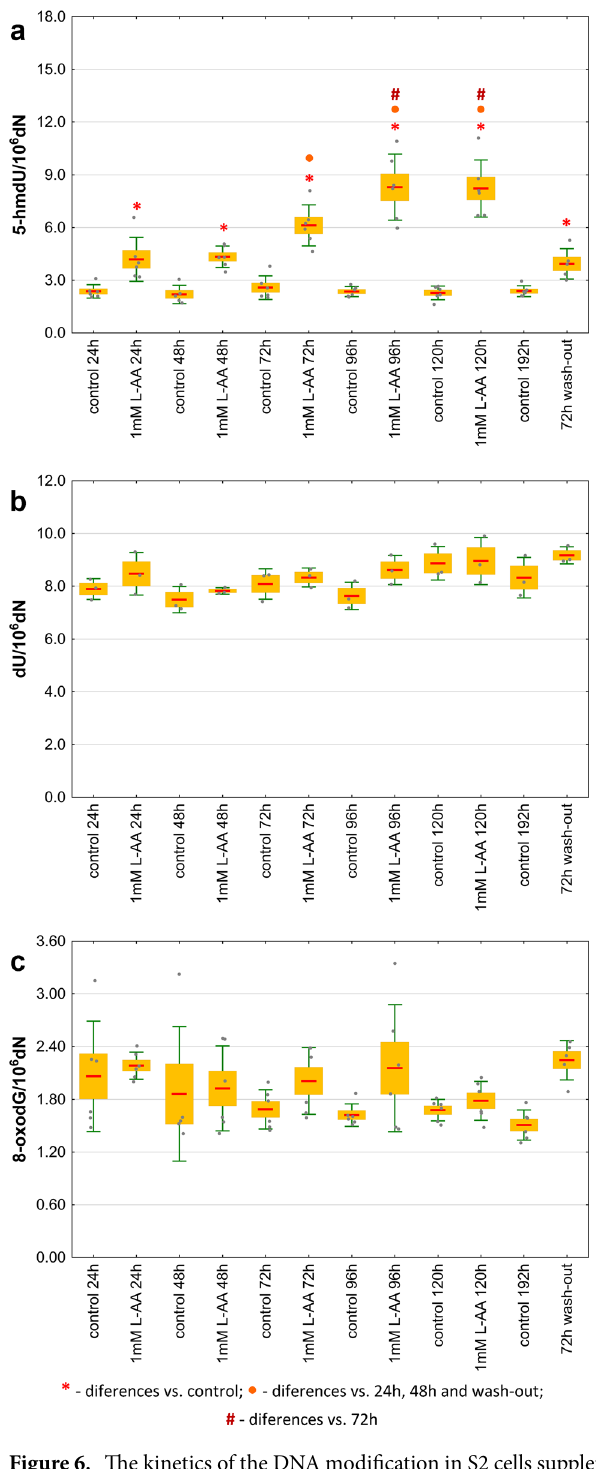
Figure 6. The kinetics of the DNA modification in S2 cells supplemented with 1 mM L-ascorbic acid and in control cells ( a ) 5-(hydroxymethyl)-2 ′ -deoxyuridine (5-hmdU), ( b ) 2 ′ -deoxyuridine (dU), ( c ) 8-oxo-7,8- dihydro-2 ′ -deoxyguanosine (8-oxodG). The results are presented as the mean, mean ± standard error and mean ± standard deviation ( p <